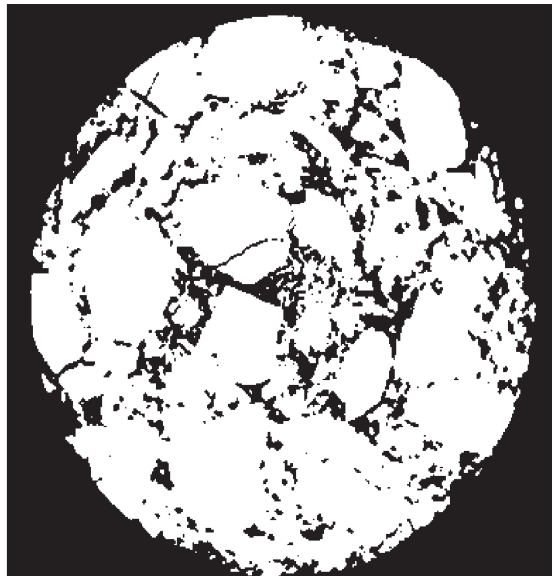
Figure 6: Sector area